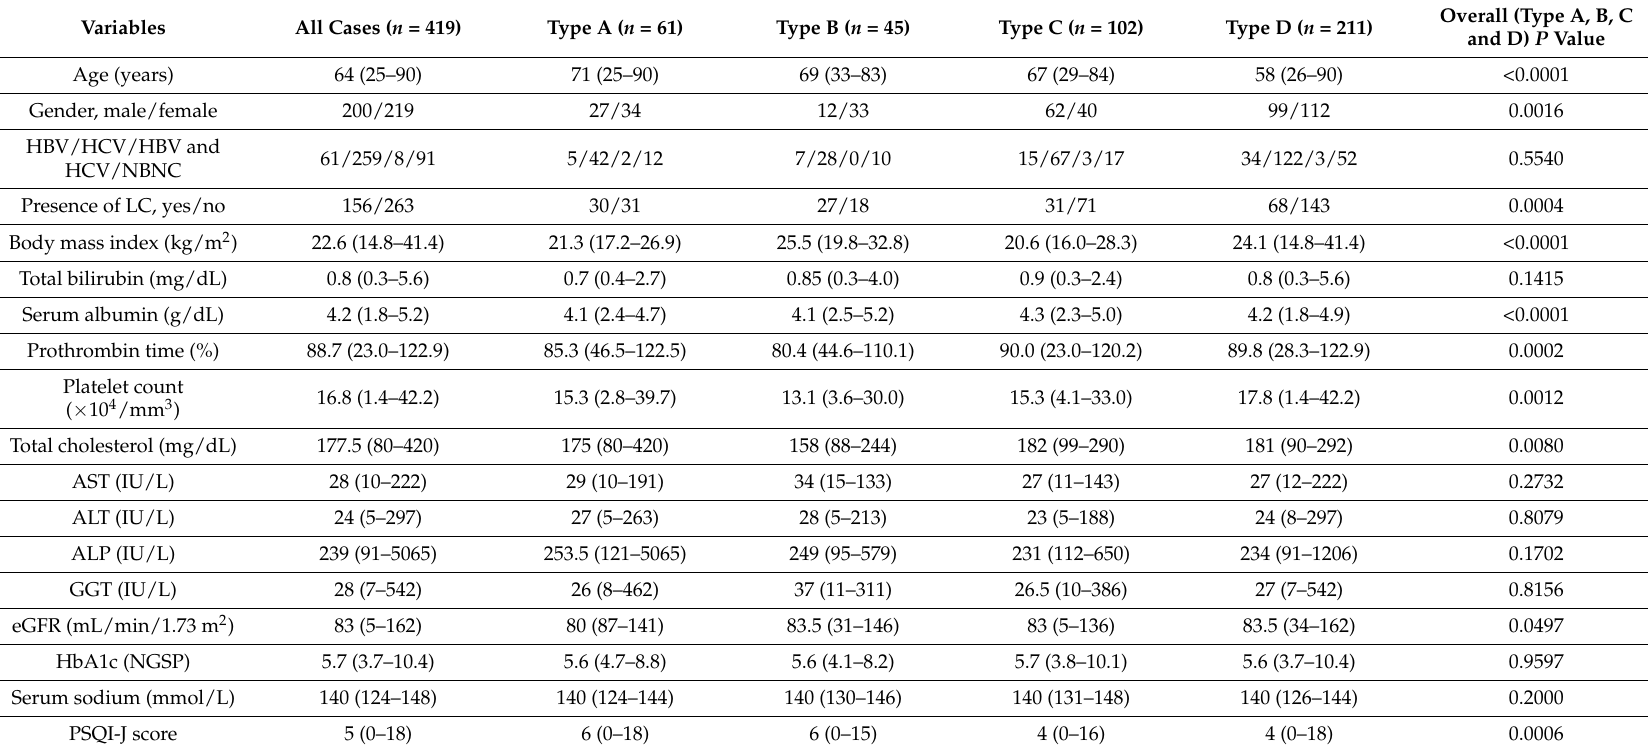
Table 2. Baseline